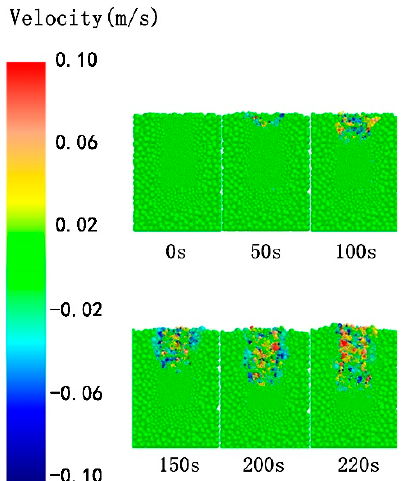
Figure 13. Temperature distribution of drill tool and simulated lunar soil particles in No. A2 at various intervals.